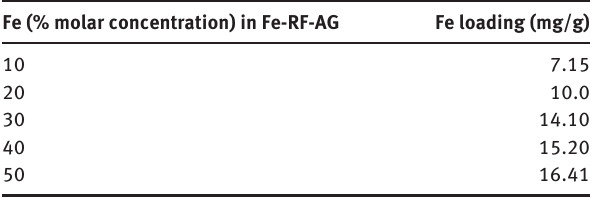
Table 1 Fe loadings in the synthesized aerogel samples using